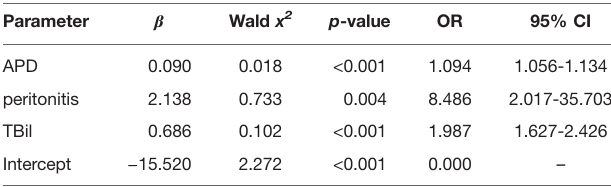
TABLE 2 | Multivariate logistic regression